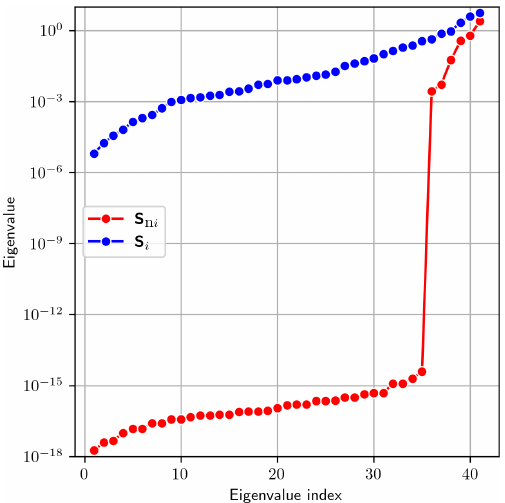
Figure 2. Eigenvalues of the CMs S i and S n i of the IASI measure-